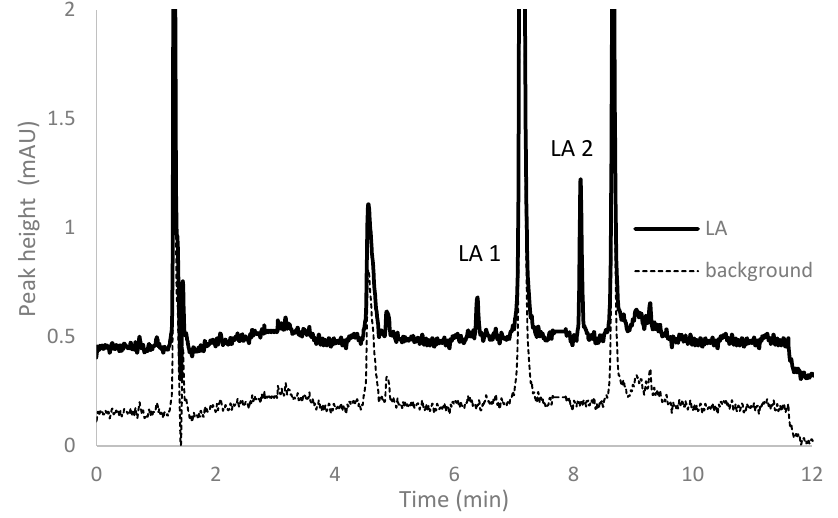
Figure 2. Chromatogram of α -lipoic acid after pre-column simultaneous reduction with tris (2- carboxyethyl)phosphine and derivatization with 1-benzyl-2-chloropyridinium bromide in low excess of the derivative reagent.